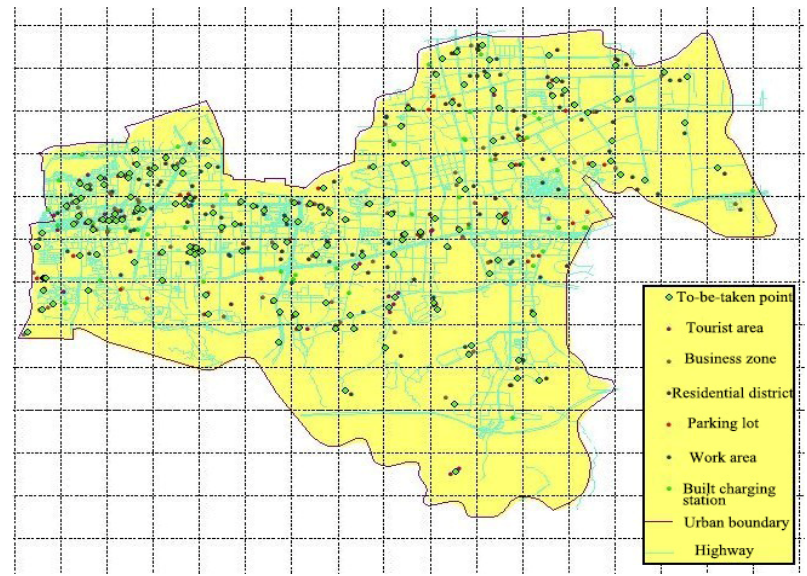
Figure 8. Distribution of pending points and demand points.